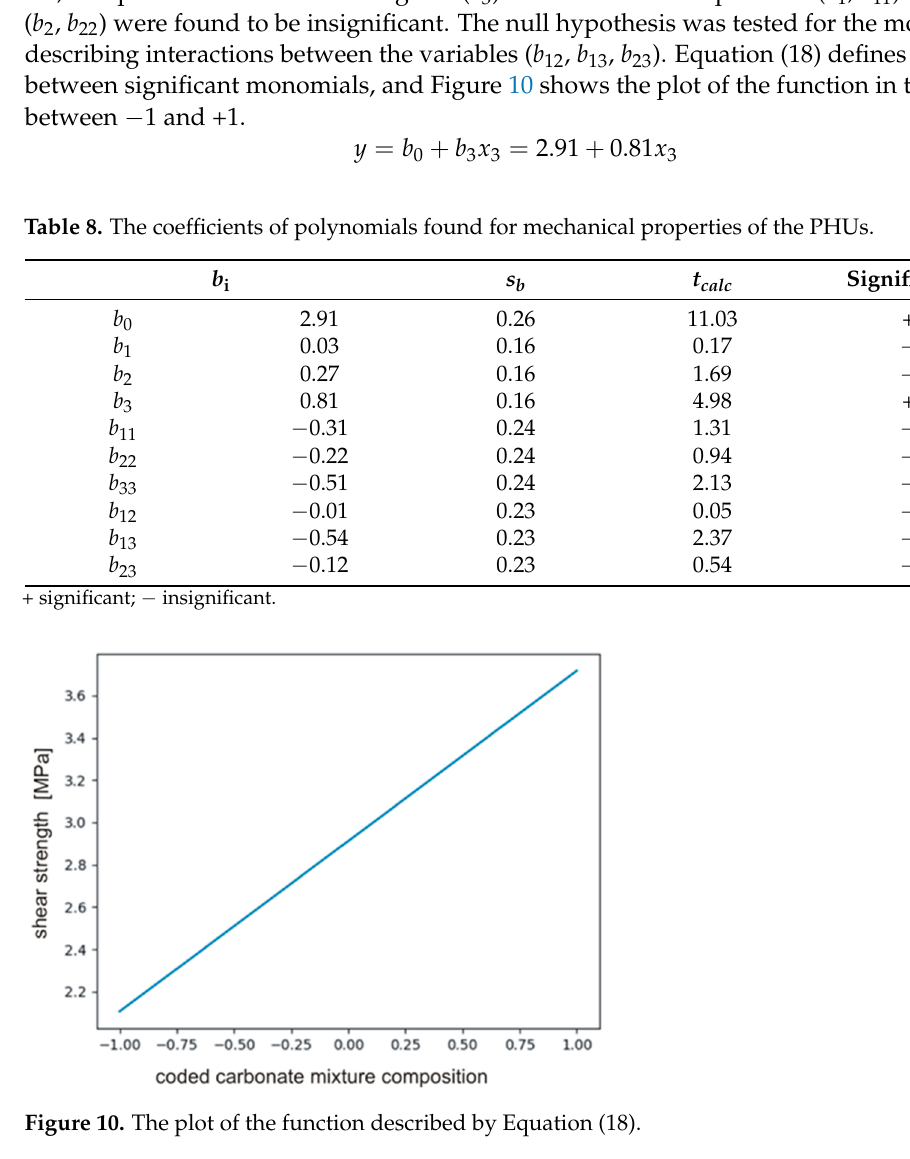
Table 9. The coefficients of polynomials found for the viscosity of the PHUs.